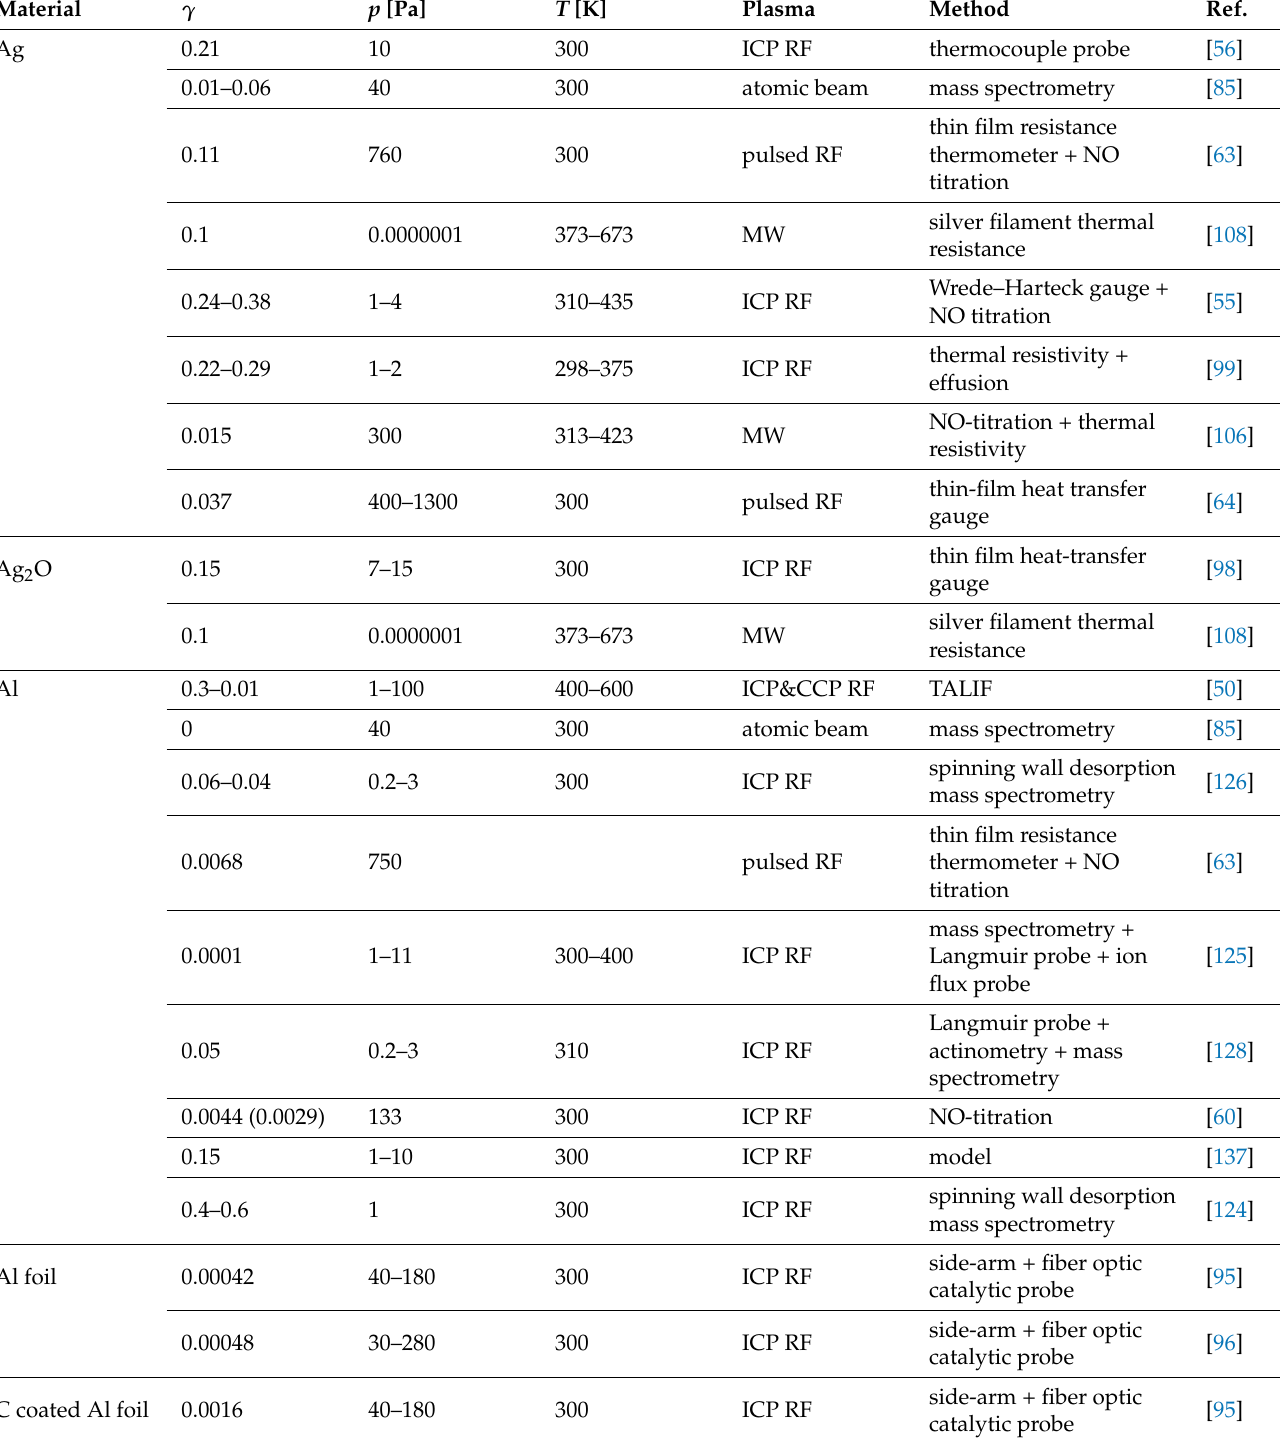
Table 2. List of recombination coefficients ( γ ) determined with different methods for various materials in different plasma systems at a given pressure (p) and surface temperature (T). In all cases, the samples for which γ was determined were kept at a floating potential. Values of γ in parenthesis were reported for «NO-poisoned»